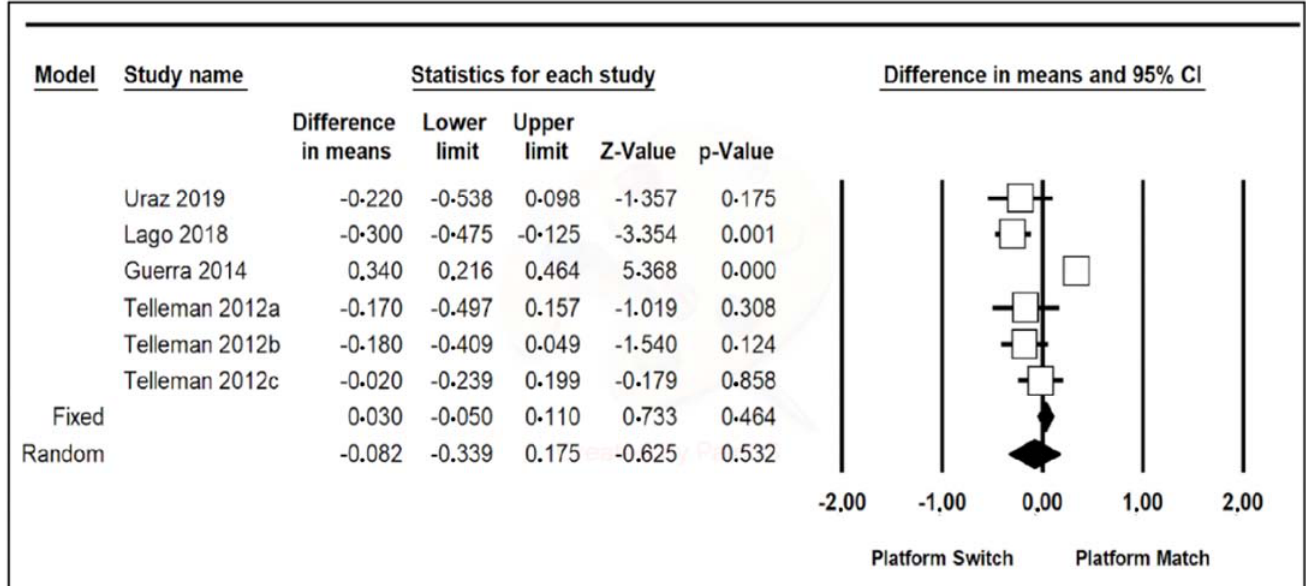
Figure 4. A forest plot increased probing depth.